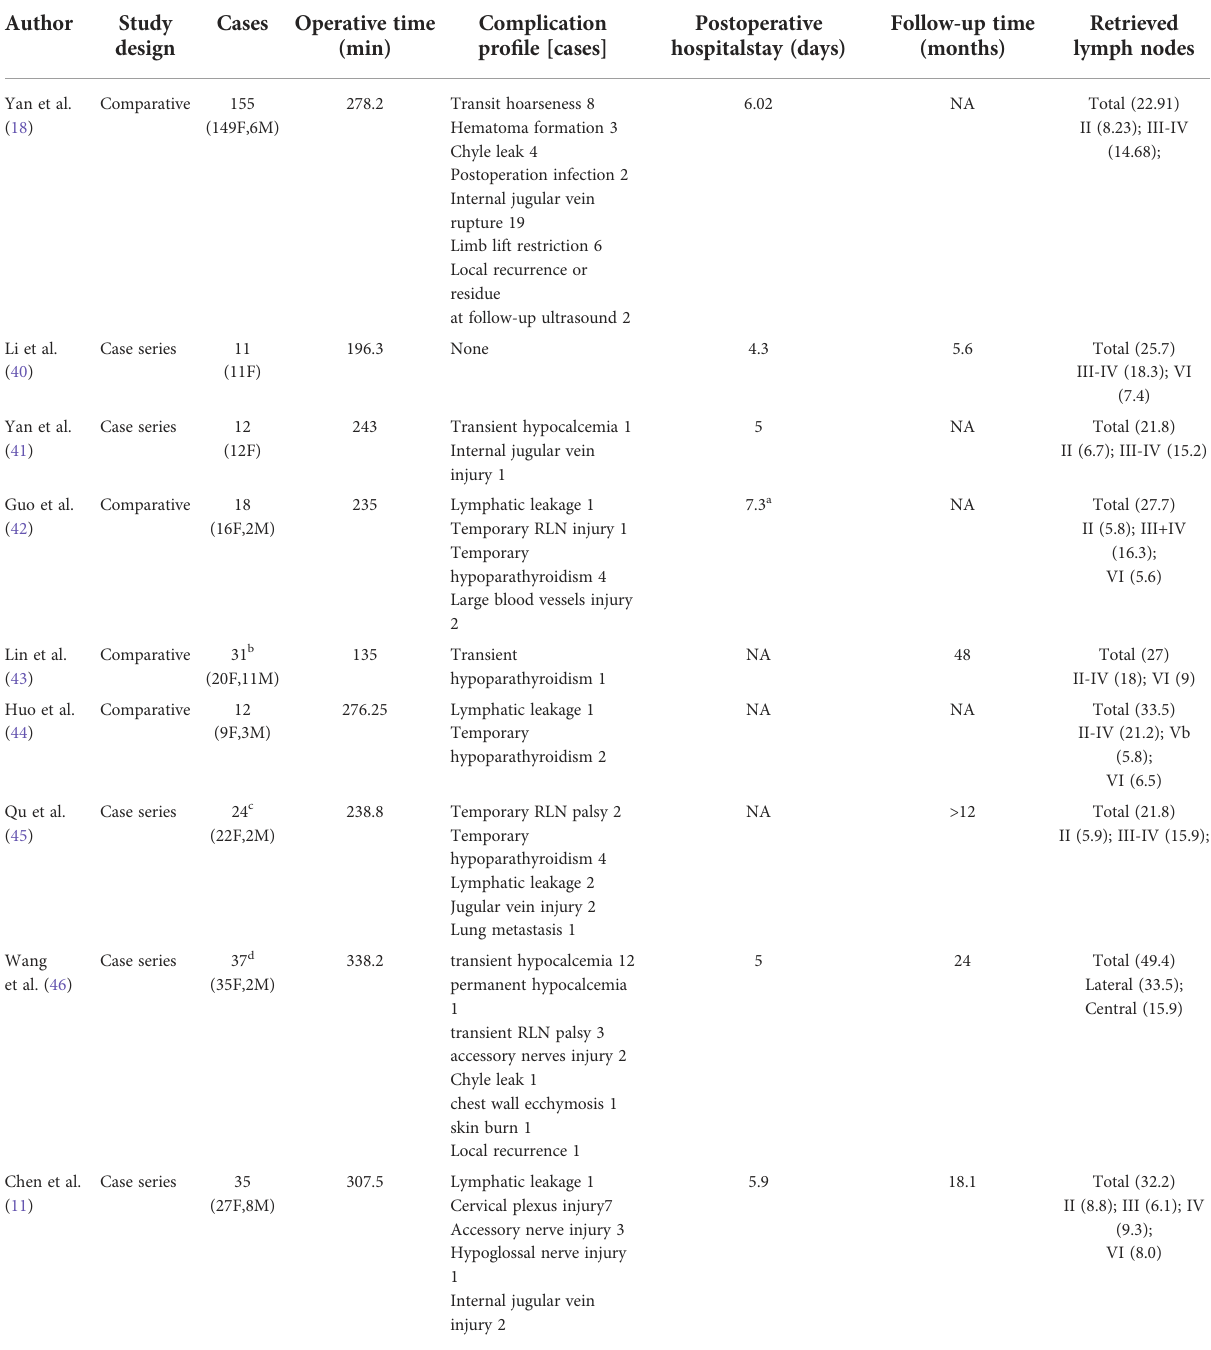
TABLE 7 Summary of studies of endoscopic LND via chest